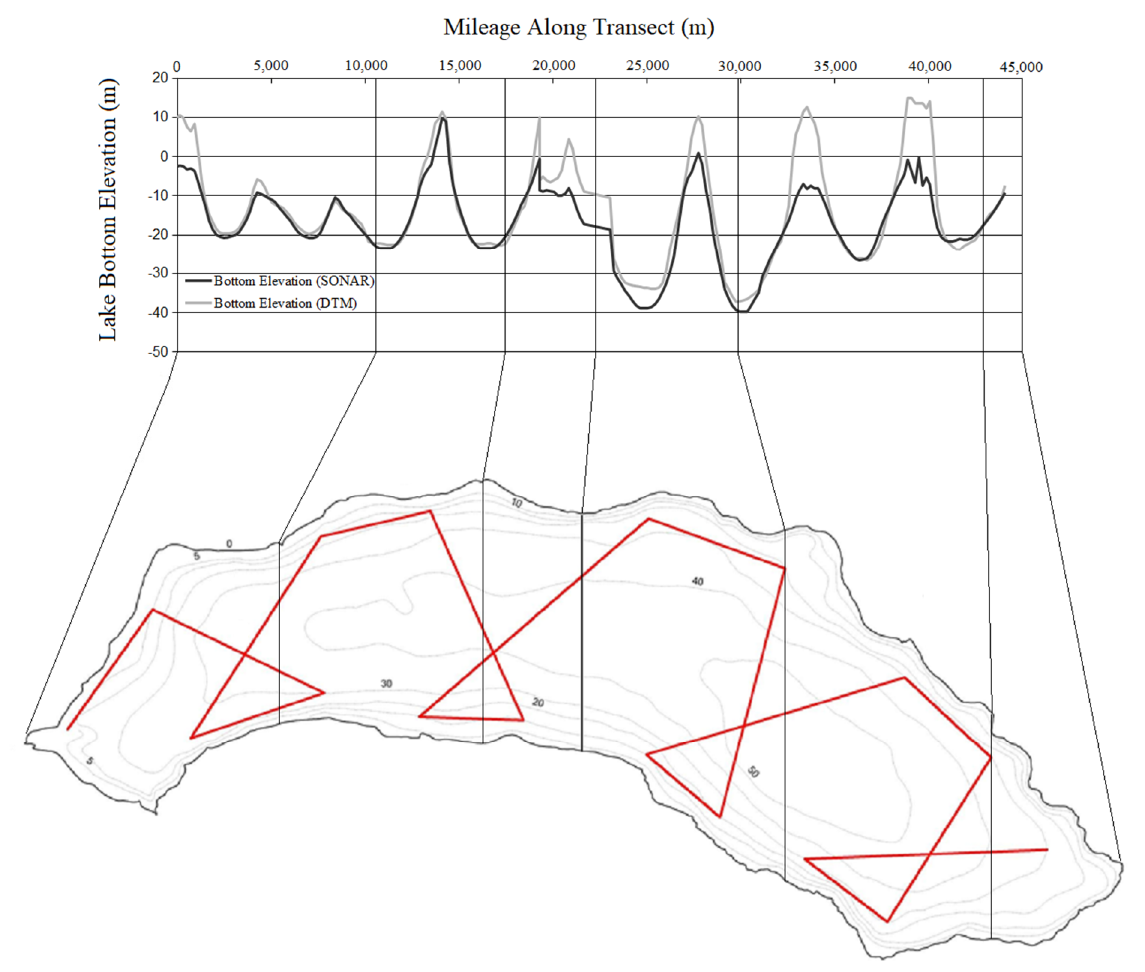
Figure 11. Absolute lake bottom elevation variation along the measured transect (with spatial reference) as derived from the DTM and the SONAR dataset.